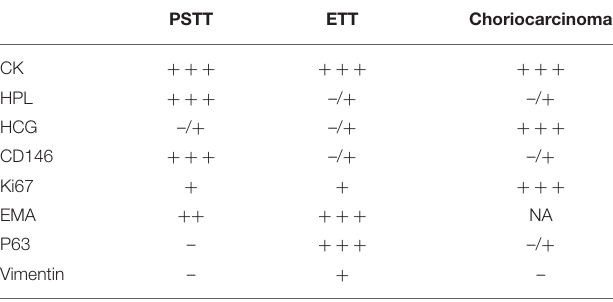
TABLE 3 | Summary of the expression patterns of different markers in three types of gestational trophoblastic neoplasia (GTN) tissues. PSTT ETT Choriocarcinoma